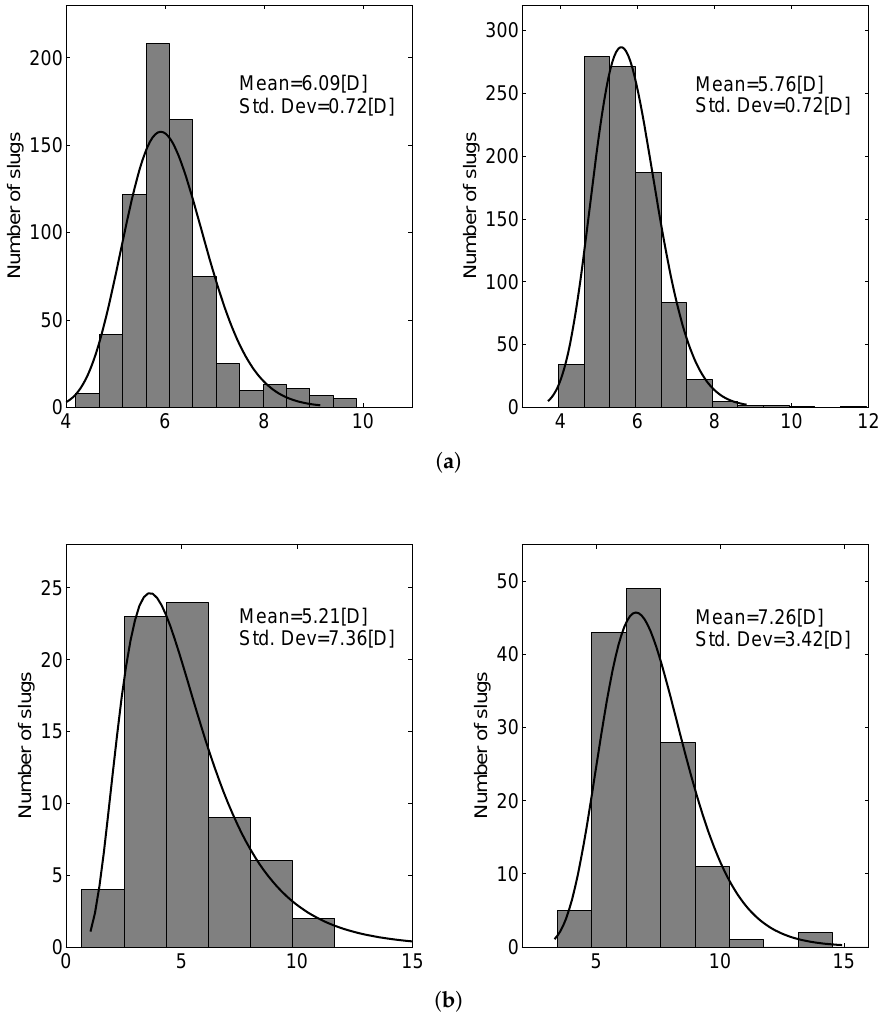
Figure 7. Typical slug length distribution for the presented geometries. ( a ) Pipe1. Left: u sg = 1.1 m/s and u sl = 1.3 m/s. Right: u sg = 1.5 m/s and u sl = 1.6 m/s; and ( b ) Pipe2. Left: u sg = 2.0 m/s and u sl = 1.0 m/s. Right: u sg = 2.5 m/s and u sl = 1.0